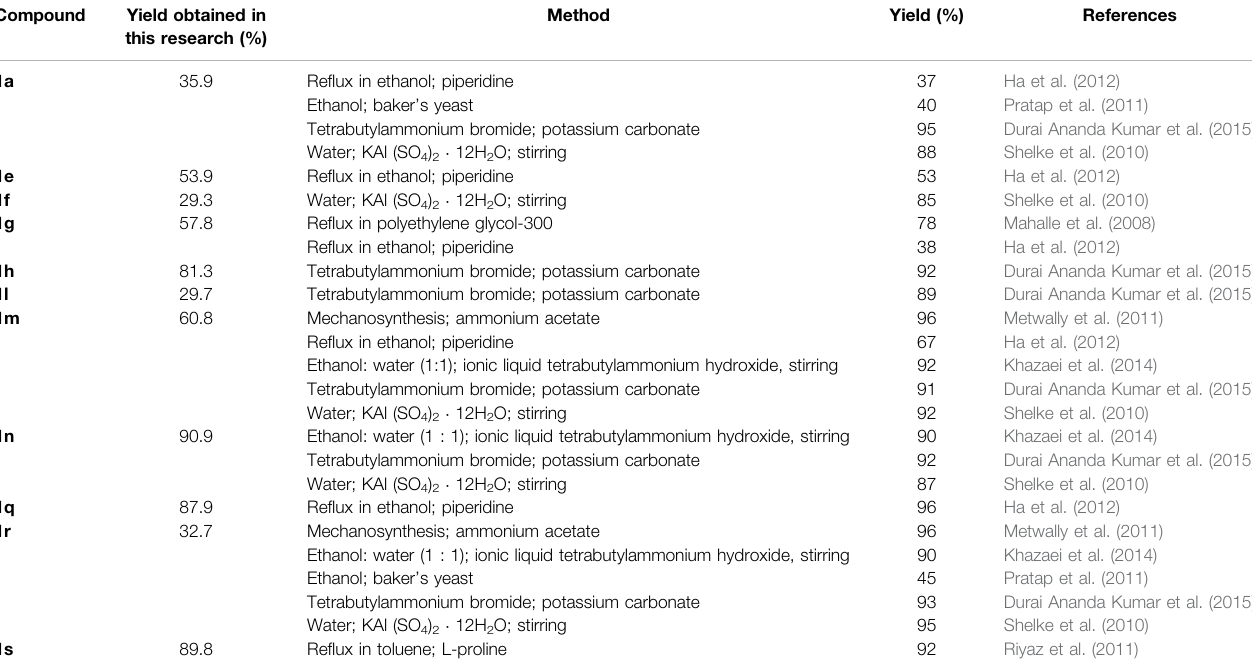
TABLE 2 | Comparison to other reported methods of thiazolidinedione synthesis. Compound Yield obtained in this research (%)